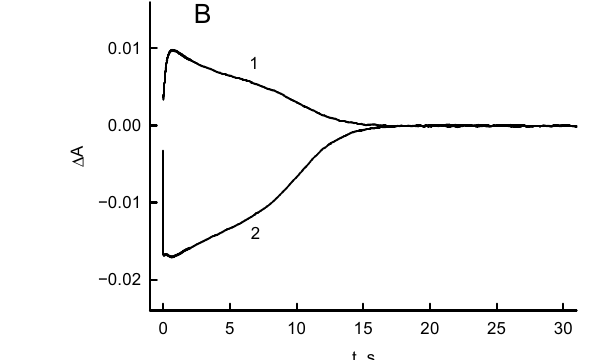
4 Figure 7. Spectra of reaction intermediates formed during the turnover of Rp FNR. Difference in absorbance is shown at several timepoints over the 450–800 nm wavelength range. Concentrations of Rp FNR, 4.0 µM; NADPH, 50 µM; and duroquinone, 250 µM (after mixing). Spectra correspond to absorbance changes at 100 ms (1), 1 s (2), 5 s (3), and 20 s (4). 4. Discussion Due to the large differences in the structure between plant-type and TrxR-type FNRs, the main focus of this work was to disclose the possible differences and similarities in their redox properties. In addition to the mechanistic aspects of studies of the reactions of